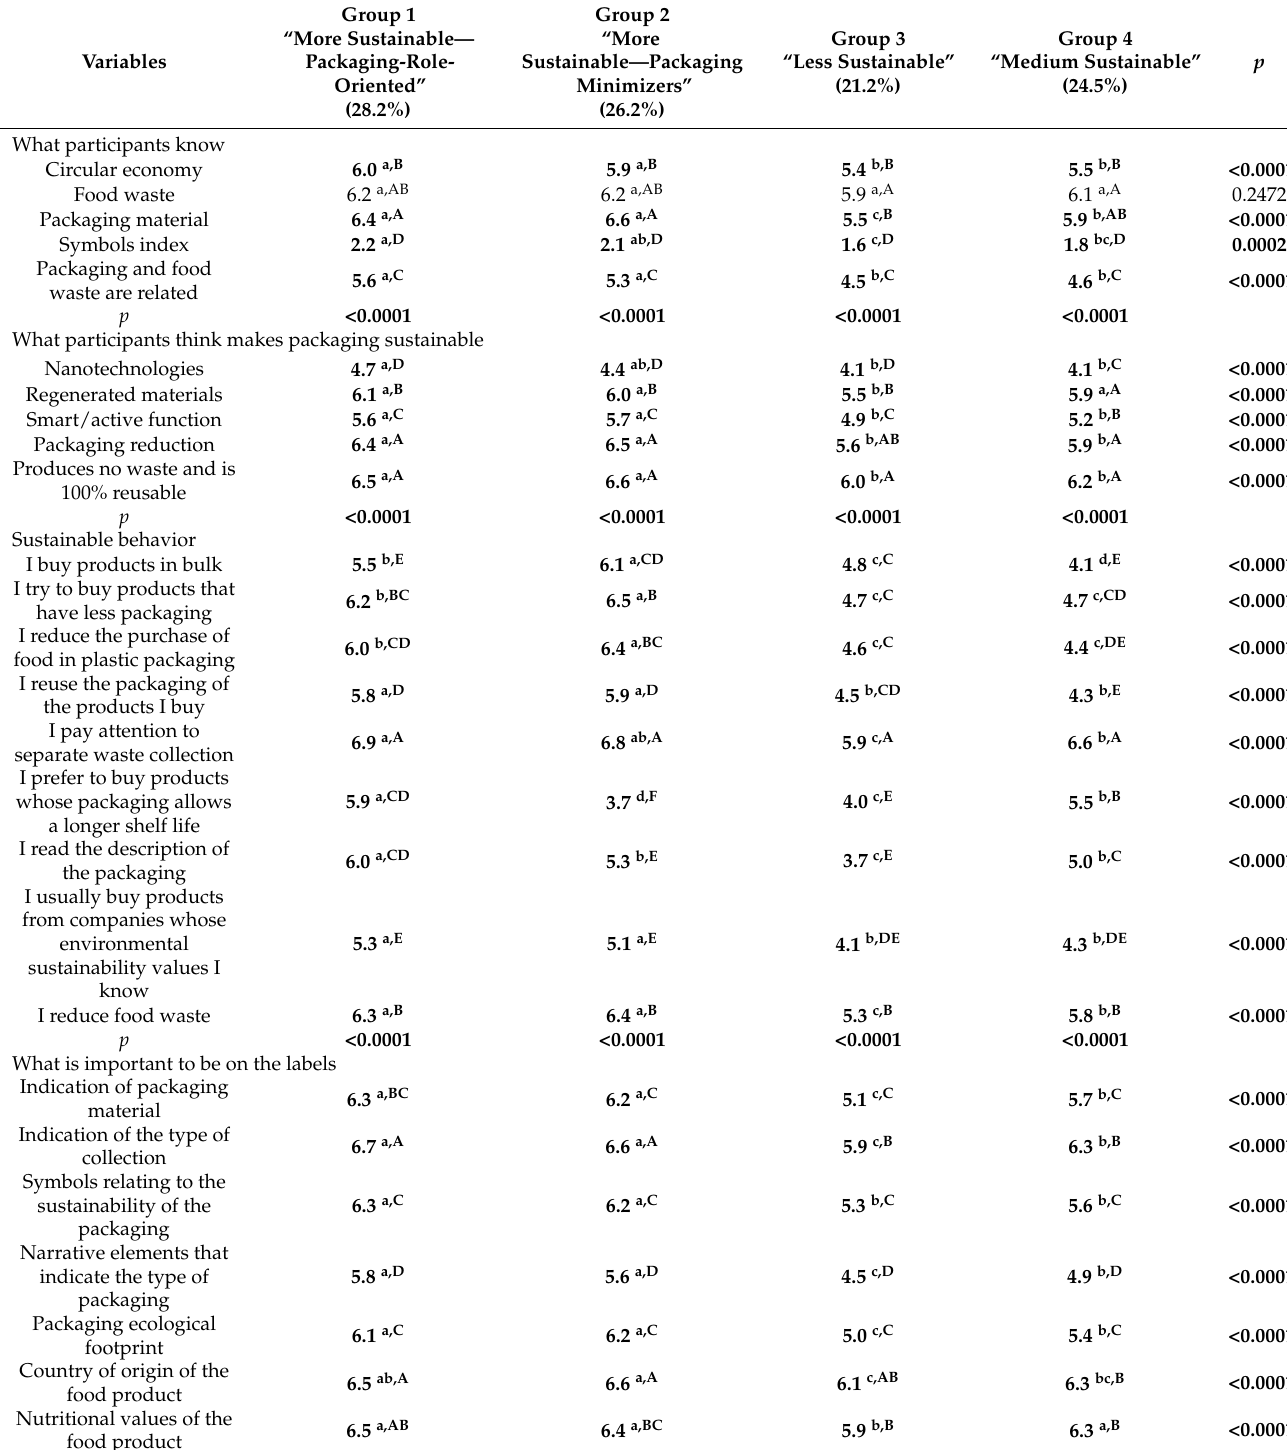
Table 4. Effect of the group on consumers’ awareness, behavior and expectations ( n =